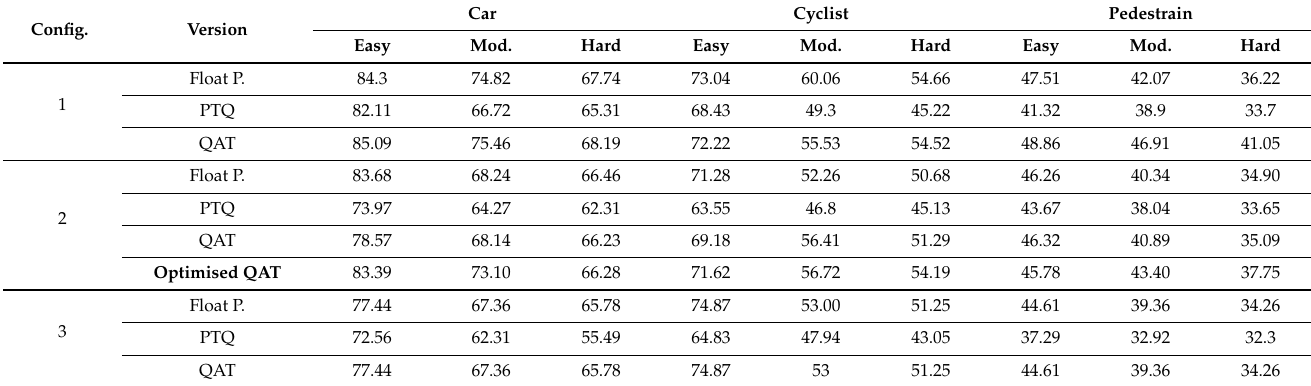
Table 14. Results of the floating-point and quantised models on KITTI 3D BBOX detection.